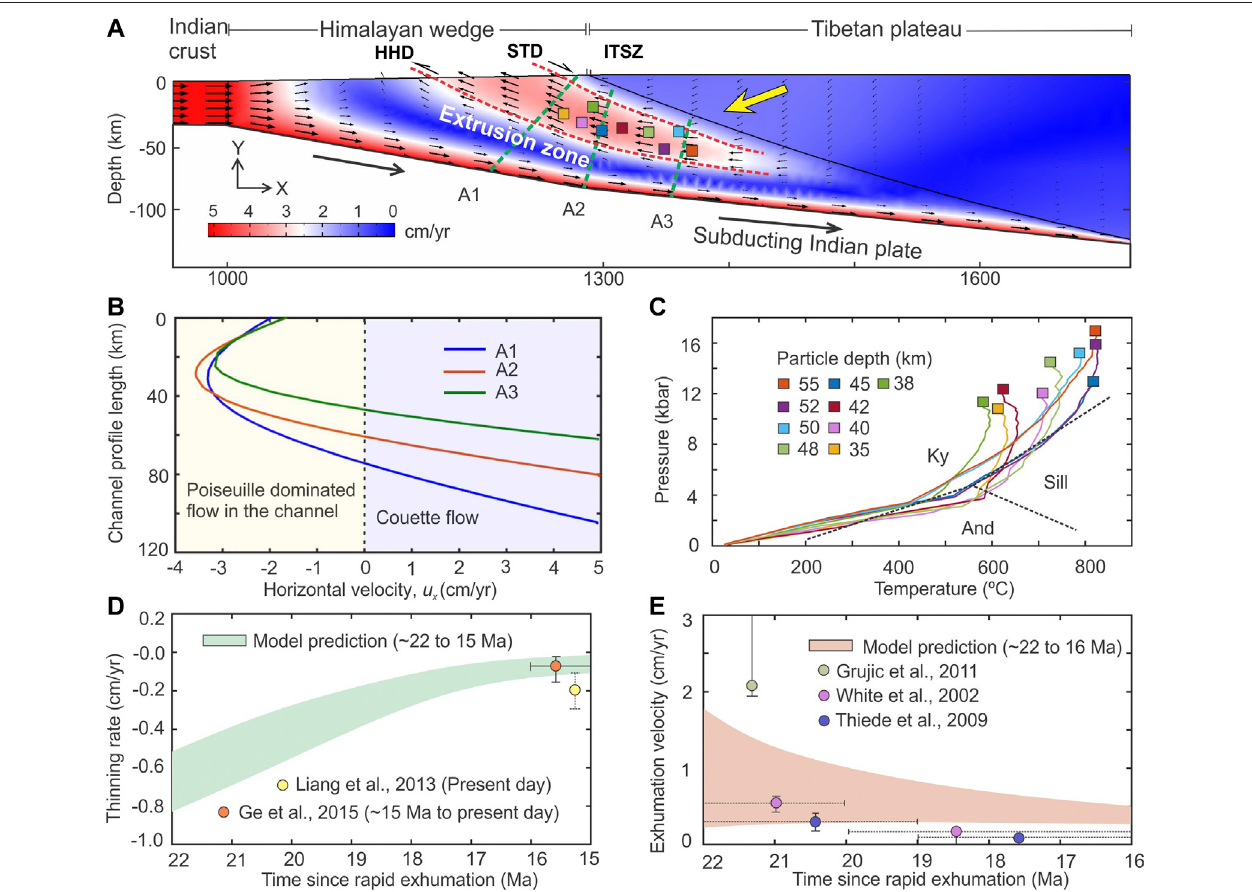
FIGURE 7 | (A) Geometry of the wedge extrusion zone and interpreted positions of important tectonic boundaries in the Himalaya-Tibet system from our thermomechanical model (MCT; Main Central Thrust; STD; South Tibetan Detachments; ITSZ; Indus Tsangpo Suture Zones). (B) Velocity pro fi les measured along A1, A2, and A3 transects (dotted green lines shown in panel (A) suggest a hybrid fl ow kinematics within the extrusion zone. The fl ow kinematics is mainly dominated by Poiseuille fl ow, whereas by Couette fl owat the base ofthe extrusion zone. (C) Model P - T paths derived from several Lagrangian particles (initial positions shown in panel (A) , exhumed to the ground surface through the extrusion zone. (D) Temporal variation of vertical thinning rate in the overriding Tibet estimated from our model, which are compared with the available fi eld data. (E) Model estimate showing the change in exhumation velocity from fast to slow with time, which are compared with available petrological